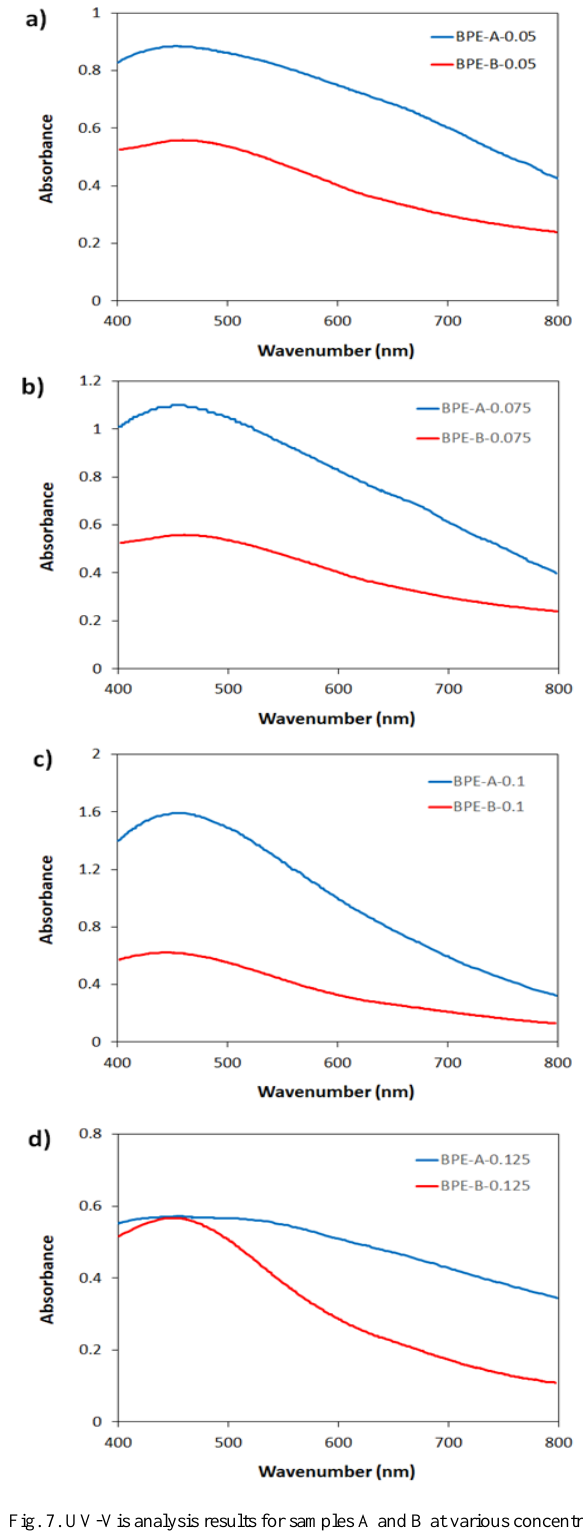
Fig. 7. UV-Vis analysis results for samples A and B at various concentration of AgNO 3 solution, i.e. a) 0.05 M; b) 0.075 M; c) 0.1 M; d) 0,125